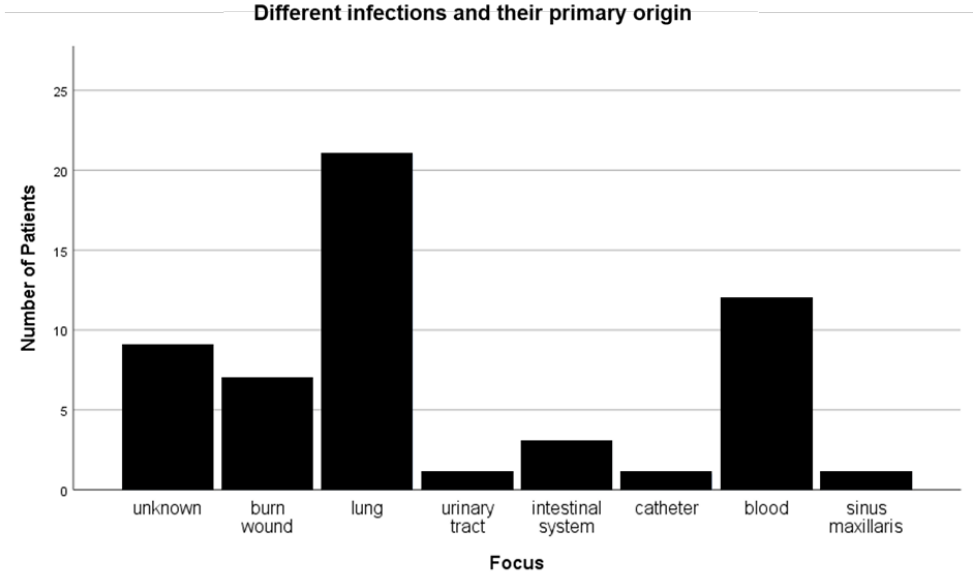
Figure 3. Different infections and their primary